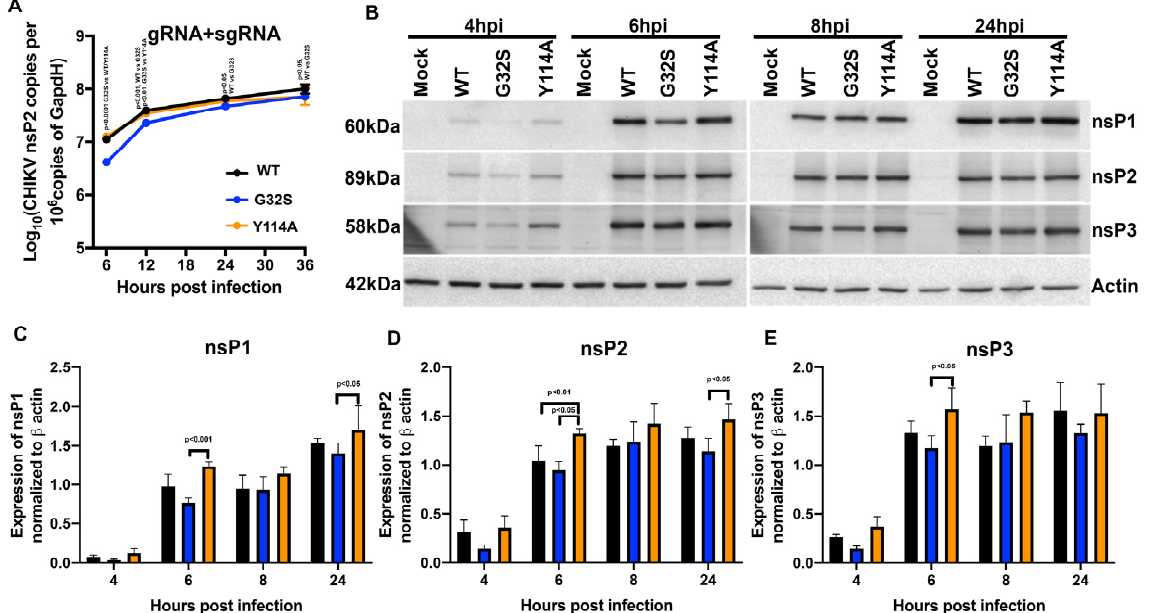
Figure 3. Effect of nsP3 MD function on astrocyte synthesis of viral RNAs and nsPs. C8-D1A cells were infected with CHIKV WT, G32S, and Y114A at an MOI of 5 and analyzed for synthesis of viral RNA and translation of nsPs. ( A ) Genomic and subgenomic (gRNA + sgRNA; E2) viral RNAs were quantified by qRT-PCR. The mean ± SD of log 10 nsP2 or E2 copies/10 6 copies of Gapdh from three independent experiments are plotted. ( B ) Representative immunoblots of viral nsP proteins at 4, 6, 8, and 24 h post infection (hpi). Lysates from C8-D1A cells infected with WT or nsP3 MD mutants were immunoblotted with antibodies to nsP1, nsP2, nsP3, and β -actin followed by secondary HRP-labeled anti-IgG were developed using a chemiluminescent detection reagent. Expression levels of nsP1 ( C ), nsP2 ( D ), nsP3 ( E ) normalized to actin were measured by densitometry from three independent experiments and the values plotted as bar graphs of the mean ± SD. p values indicate the significance of differences between WT and G32S/Y114A or between G32S and Y114A at the indicated time points.